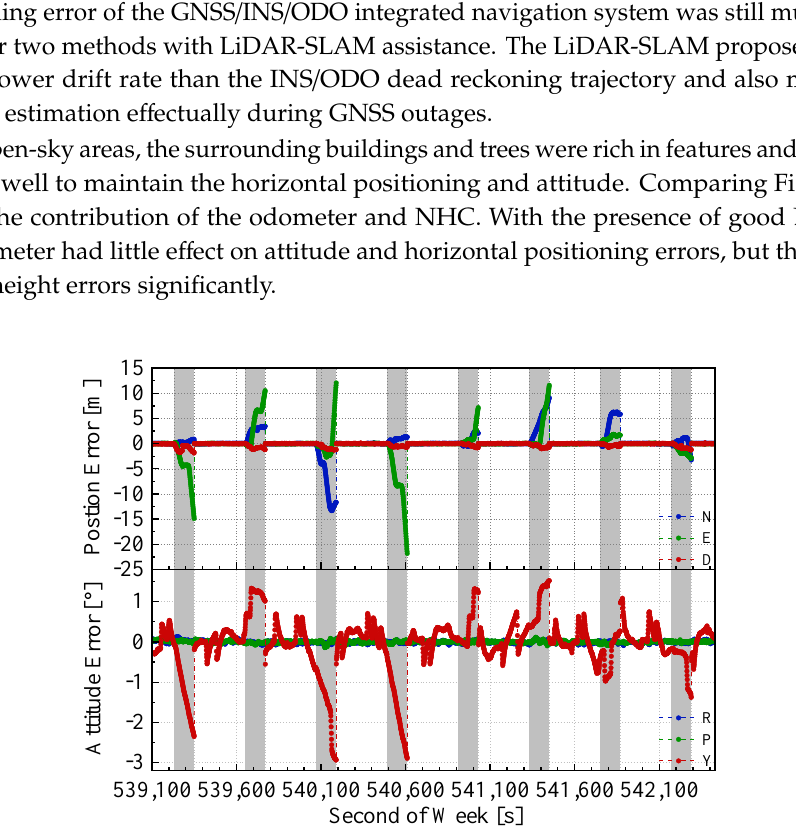
Figure 8. GNSS/INS/ODO navigation errors in test #2 (with 2 min GNSS outages).